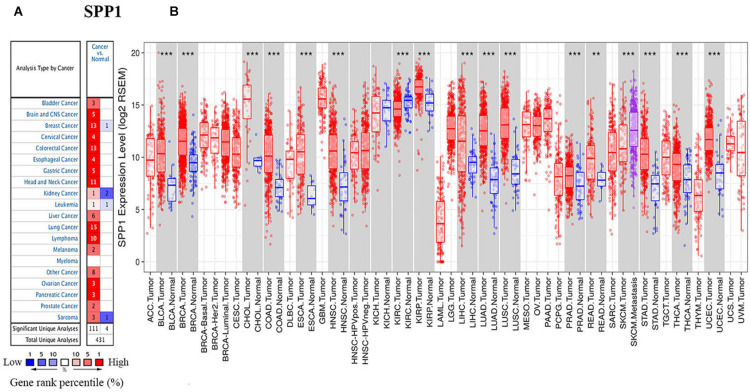
SPP1 levels in diverse cancer types and normal tissues. (A) High (red) or low (blue) SPP1 levels in various cancer types relative to non-carcinoma tissue samples based on the Oncomine database. (B) SPP1 expression in diverse cancers relative to the non-carcinoma tissue samples based on TCGA database was studied through TIMER. BLCA, bladder urothelial carcinoma; ACC, adrenocortical carcinoma; BRCA, breast invasive carcinoma; CHOL, cholangiocarcinoma; CESC, cervical squamous cell carcinoma and endocervical adenocarcinoma; ESCA, esophageal carcinoma; COAD, colon adenocarcinoma; HNSC, head and neck cancer; GBM, glioblastoma multiforme; KIRC, kidney renal clear cell carcinoma; KICH, kidney Chromophobe; LIHC, liver hepatocellular carcinoma; KIRP, kidney renal papillary cell carcinoma; LUSC, lung squamous cell carcinoma; LUAD, lung adenocarcinoma; PAAD, pancreatic adenocarcinoma; OV, ovarian serous cystadenocarcinoma; READ, rectum adenocarcinoma; PRAD, prostate adenocarcinoma; THCA, thyroid carcinoma; STAD, stomach adenocarcinoma; UCEC, uterine corpus endometrial carcinoma; THYM, thymoma; UVM, uveal Melanoma; and UCS, uterine carcinosarcomas (**P < 0.01, ***P < 0.001).